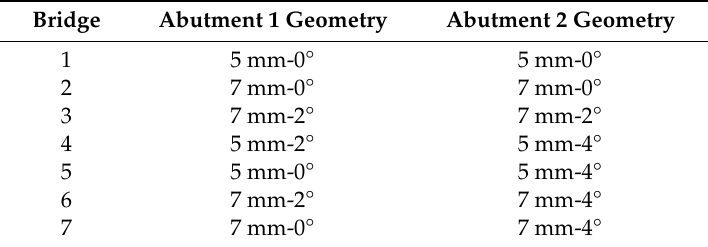
Table 1. Tested dental bridge models: height (mm) and taper angle ( ◦ ) of each abutment.